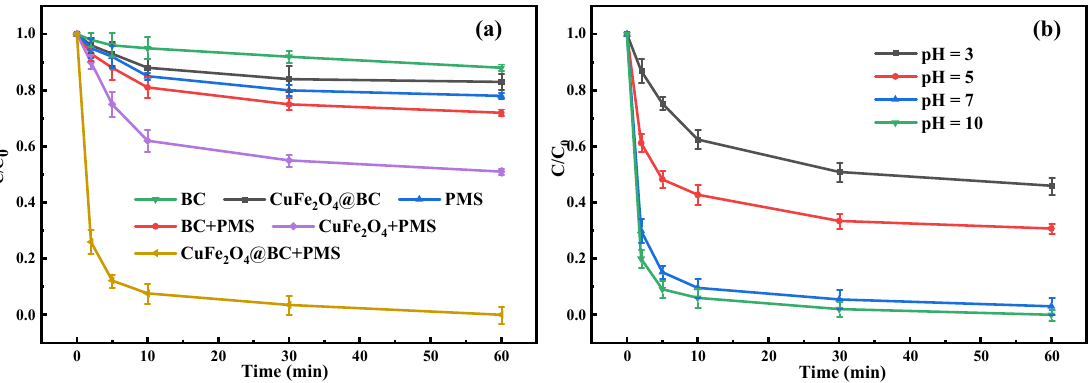
Figure 4. ( a ) CIP degradation efficiency activated by various catalysts. ( b ) Initial pH in the CuFe 2 O 4 @BC/PMS system. Reaction conditions: [CIP] = 10 mg/L, [PMS] = 2.5 mM, [catalysts] = 0.1 g/L (for a , b ), initial pH = 7 (for a ), initial pH = 3~10 (for b ), temperature = 25 °C.